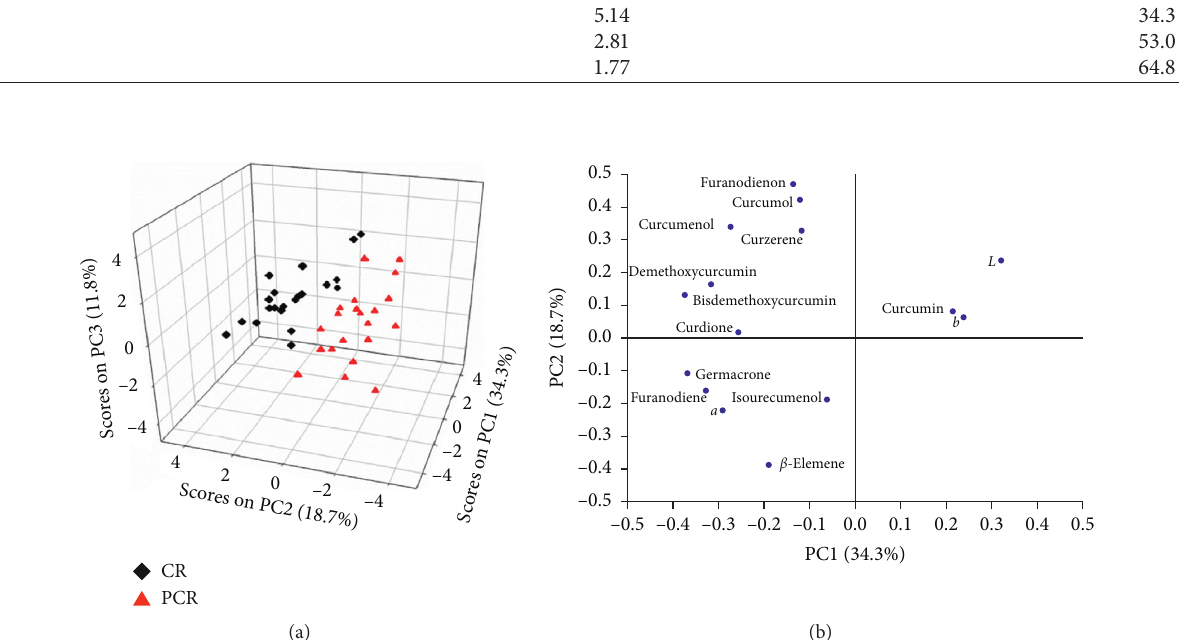
Table 4: Diagnostics of the PCA model for differently prepared slices of Zedoray Rhizome samples. Number of PCs